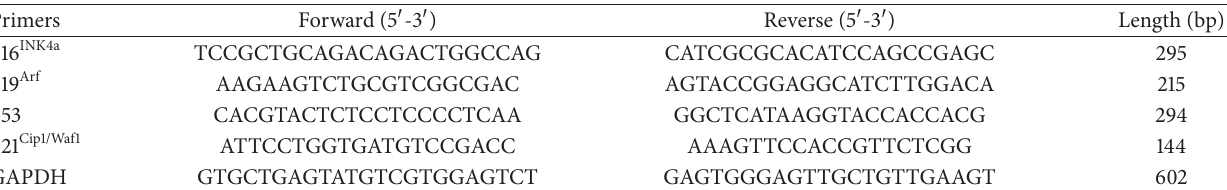
Table 1: The unique PCR